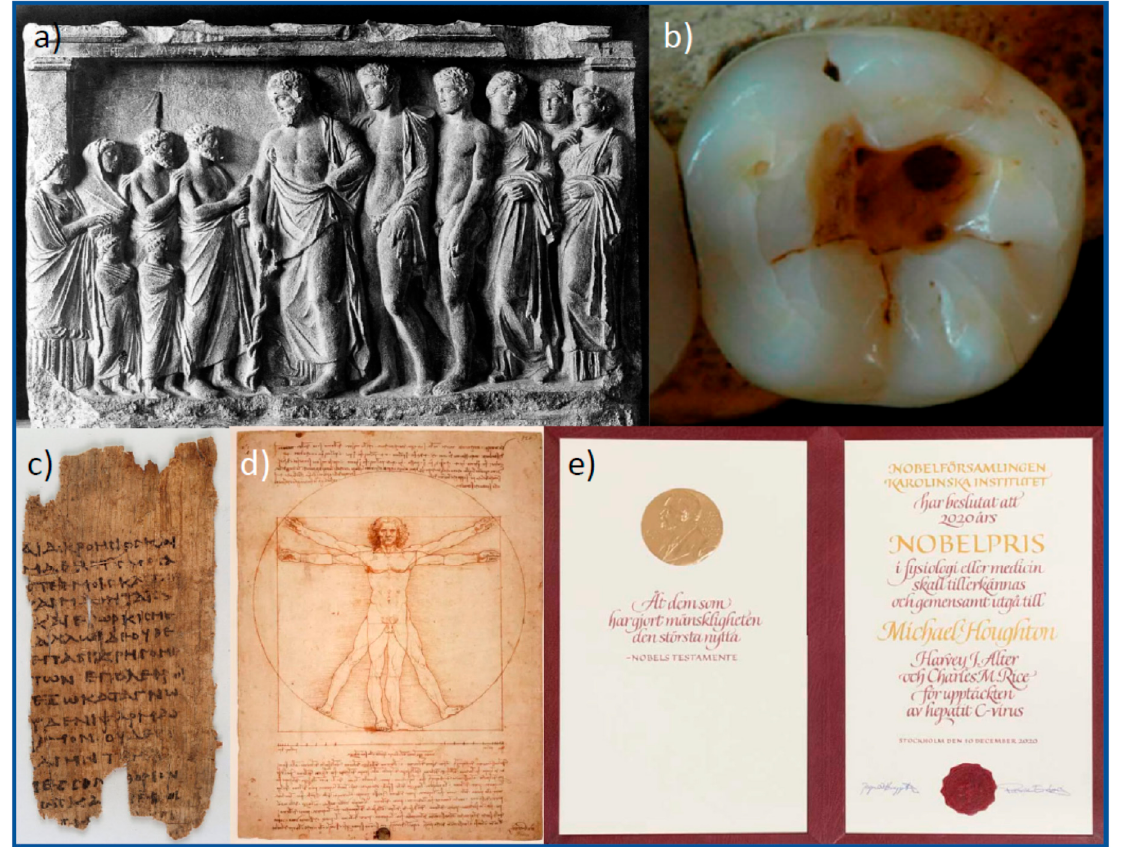
Figure 40. Diagram of the progress of medicine throughout history: ( a ) Greek votive relief ca 470–450 BC, found at Thyrea, Greece, now in the National Archeological Museum in Athens, Greece, depicting Asclepius as the god of medical art in Greek mythology with his sons Podalirius and Machaon and his three daughters, with supplicants; ( b ) tooth the lower right third molar (RM3) of the man from Villabruna, today in Italy, from the Late Upper Palaeolithic about 14,000 years ago with traces of intervention to repair the cavity and relieve pain; ( c ) a fragment of Papyrus Oxyrhynchus 2547, found in Egypt from the oath of Hippocrates dating from the 3rd-century BC; ( d ) the drawing “Le proporzioni del corpo umano secondo Vitruvio”, created in pencil and ink on paper by Leonardo da Vinci and disseminated around 1490; ( e ) a copy of the Nobel Prize in Physiology or Medicine 2020 diploma recently awarded to Prof. Michael Houghton of the University of Alberta in Edmonton, Canada “for the discovery of Hepatitis C virus.”.